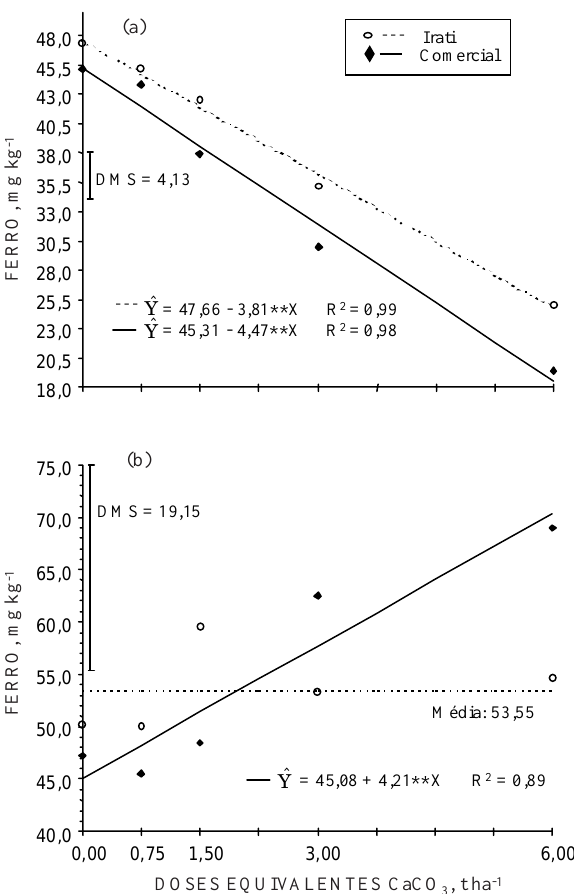
Figura 2. Teores de Fe no solo extraído com DTPA- TEA (a) e concentração média de Fe na planta de milho (b) em função de doses crescentes de , e dos distintos equivalentes de CaCO 3 materiais corretivos (DMS: Diferença mínima significativa para diferentes materiais corretivos a uma